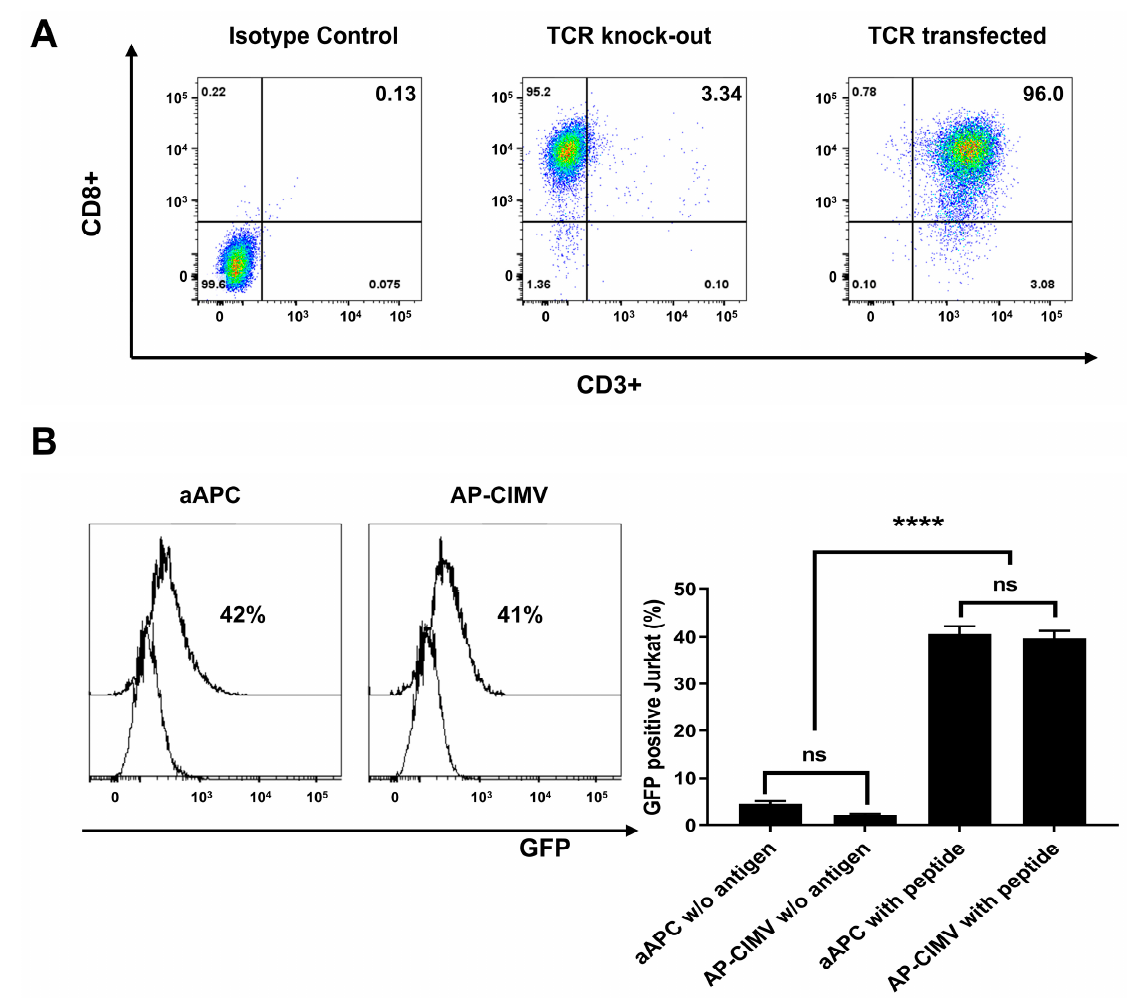
Figure 4. Activation of Jurkat reporter cells expressing CMV-specific TCR by aAPCs and AP-CIMVs expressing HLA-A*02:01 and loaded with CMV pp65 peptide. (NLVPMVATV) ( A ) In Jurkat cells in which the endogenous TCR was removed by Crispr/cas9, CD3 molecules do not appear on the cell surface. When mRNAs of HLA-A*02:01-restricted and CMV pp65-specific TCR alpha and beta genes were transferred, the reappearance of CD3 molecules on the cell surface indicated expression of the transferred TCR gene. ( B ) Induction of GFP expression in Jurkat reporter cells expressing specific TCR stimulated by aAPCs or AP-CIMVs expressing HLA-A*02:01 loaded with CMV pp65 epitope peptide in the negative control group, aAPC or AP-CIMVs alone without antigen peptide was used for stimulation. Error bars display mean values ± SD of triplicate. p value was calculated via one-way ANOVA. **** p < 0.0001.